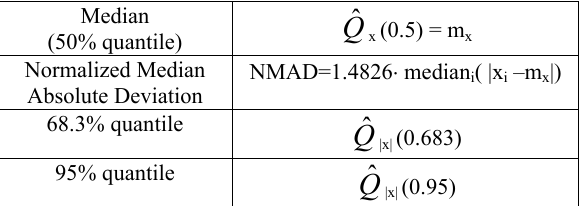
Table 1. Robust accuracy measures for a variable x Also radial errors can be generated by